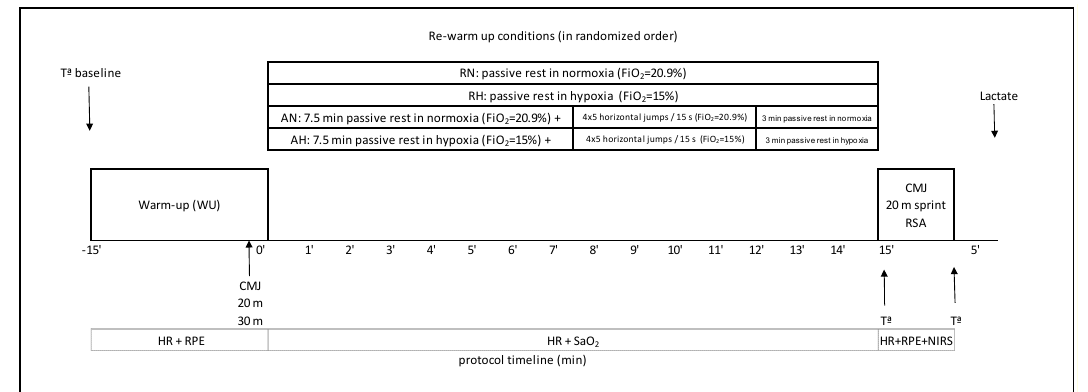
Figure 1. Schematic representation of experimental design. RN: rest in normoxia, AN: activity in normoxia; RH: rest in hypoxia; AH: activity in hypoxia, Tª: temperature; HR: heart rate; RPE: rating of perceived exertion; NIRS: near-infrared spectroscopy; SaO 2 : arterial oxygen saturation; WU: warm-up; RSA: repeat sprint ability test; CMJ: countermovement